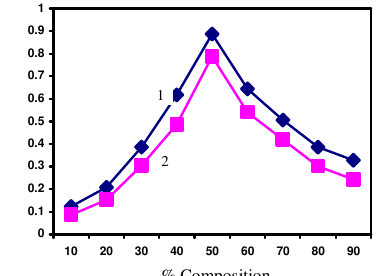
Figure 6. Plots of O.D. vs. % composition of metal ions -Gd(III)